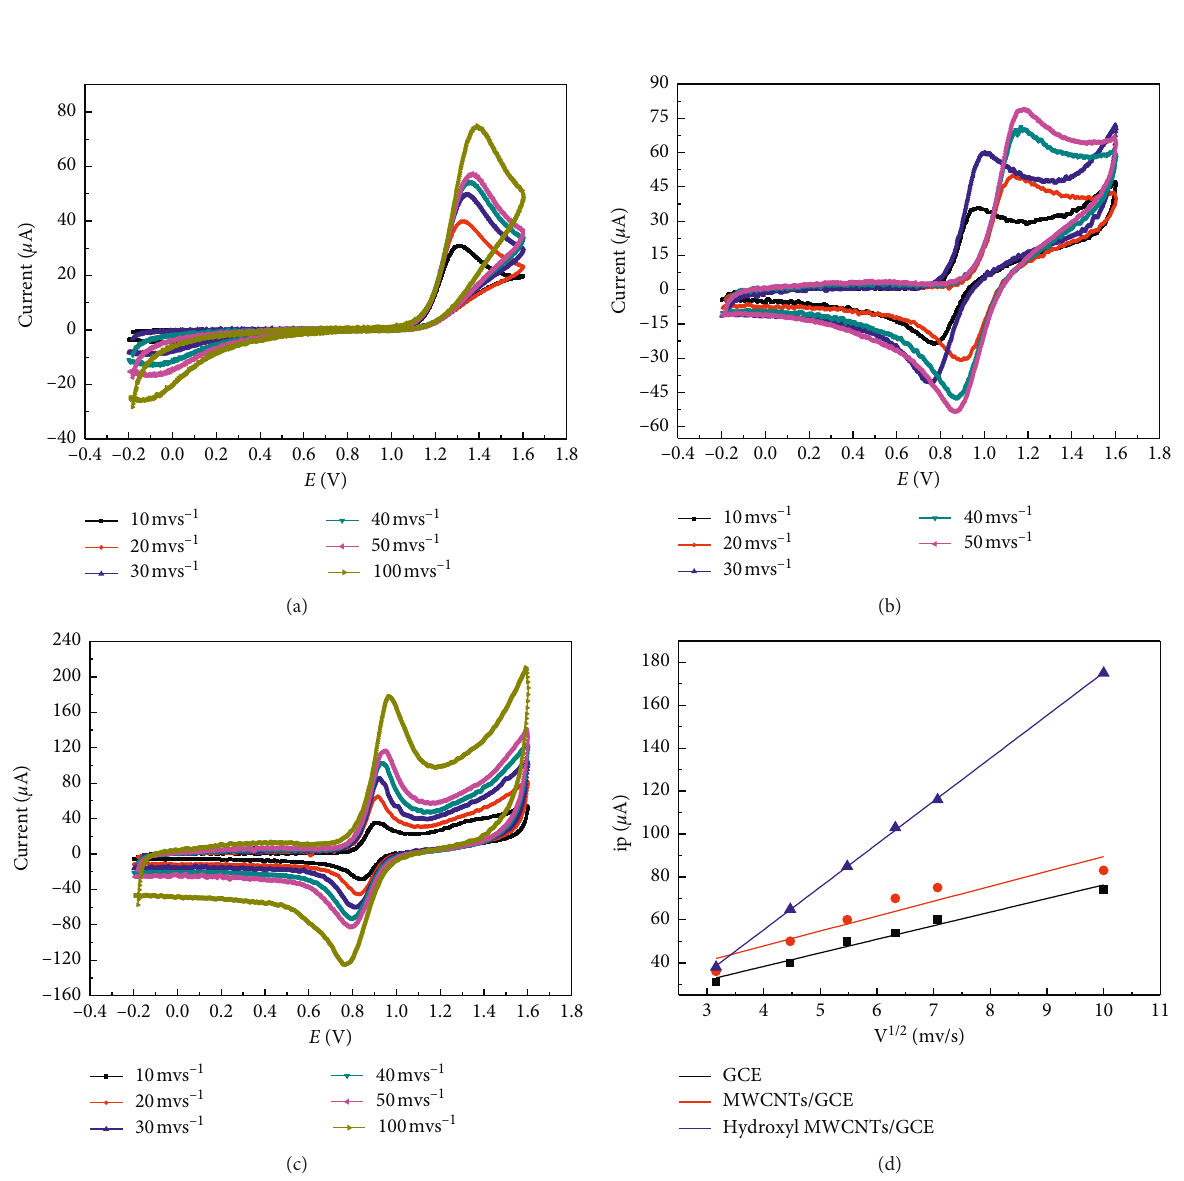
Figure 4: Cyclic voltammetry curves of GCE (a), MWCNTs/GCE (b), and hydroxyl MWCNTs/GCE (c) under different scan rates in 0.1M VOSO 4 +2M H 2 SO 4 and the relationship between oxidation peak currents and square root of scan rate